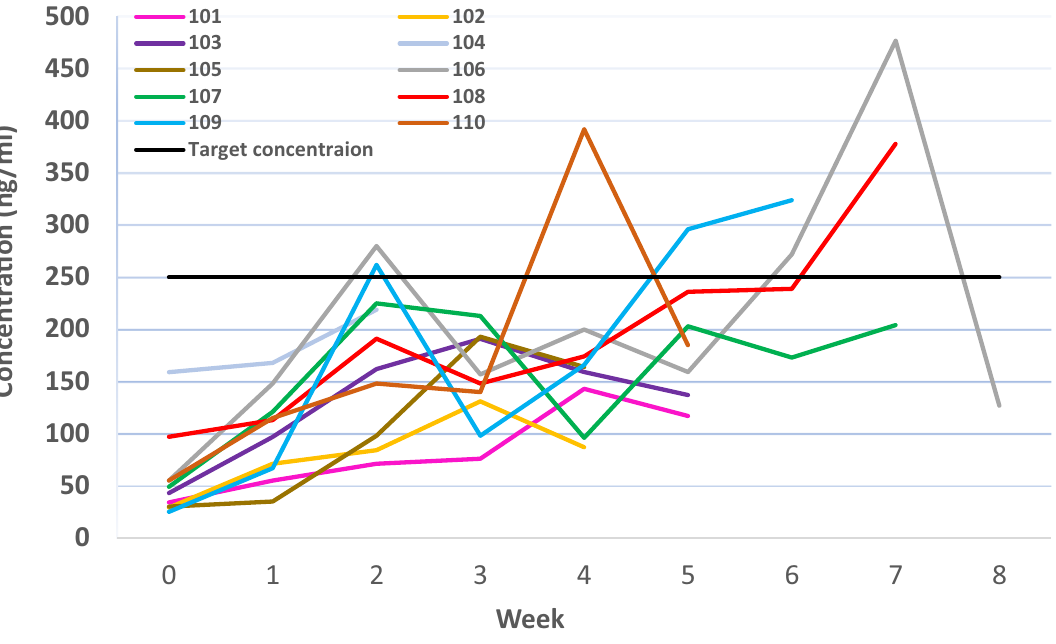
Figure 5. Graphical presentation of observed weekly serum-mebendazole concentrations during the pharmacokinetic (w 0) and treatment phases (w 1–8) for each of the study subjects. The horizontal line indicates the target